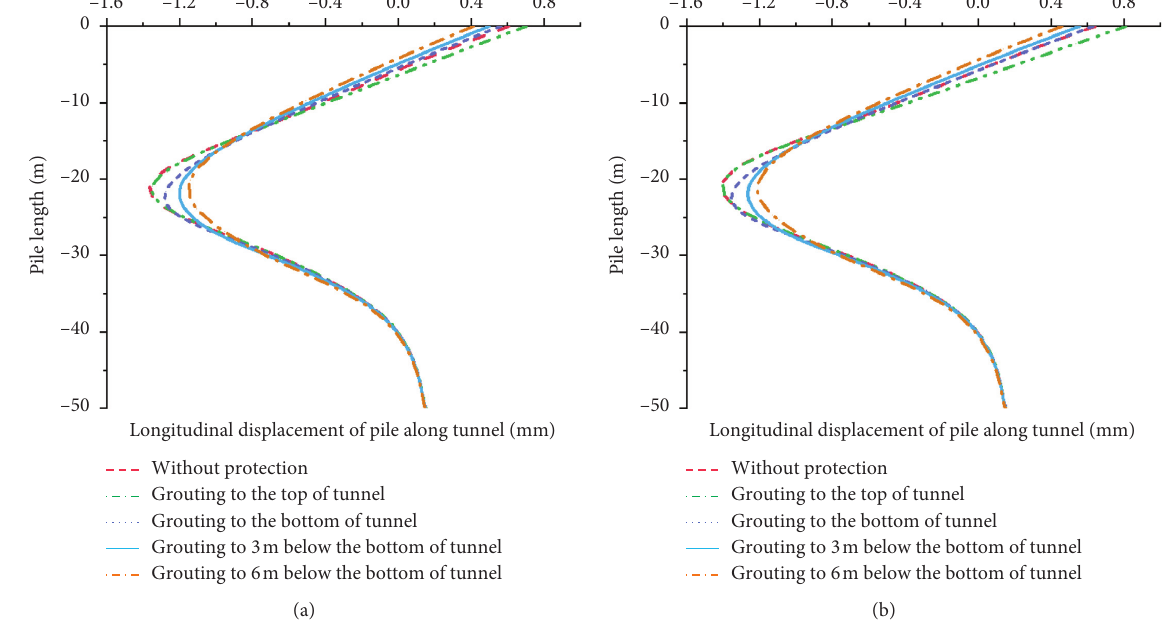
Figure 16: Longitudinal displacement of the pile along the tunnel: (a) 2 rings before arriving at the pile; (b) arriving at the pile.